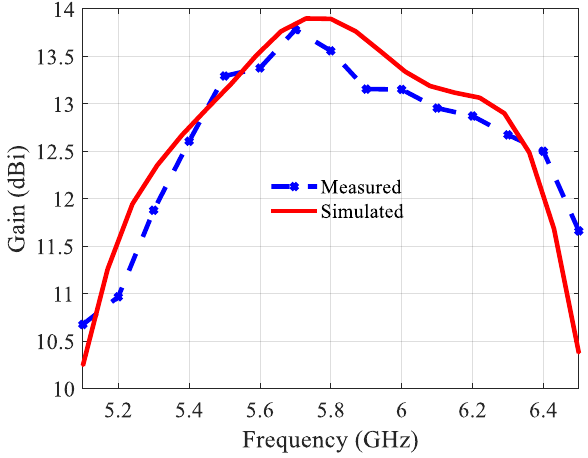
Figure 18. Simulated and measured normalized radiation patterns of the 2 × 4 proposed antenna array with an air layer at 5.8 GHz: ( a ) In the E-plane ( b ) In the H-plane.